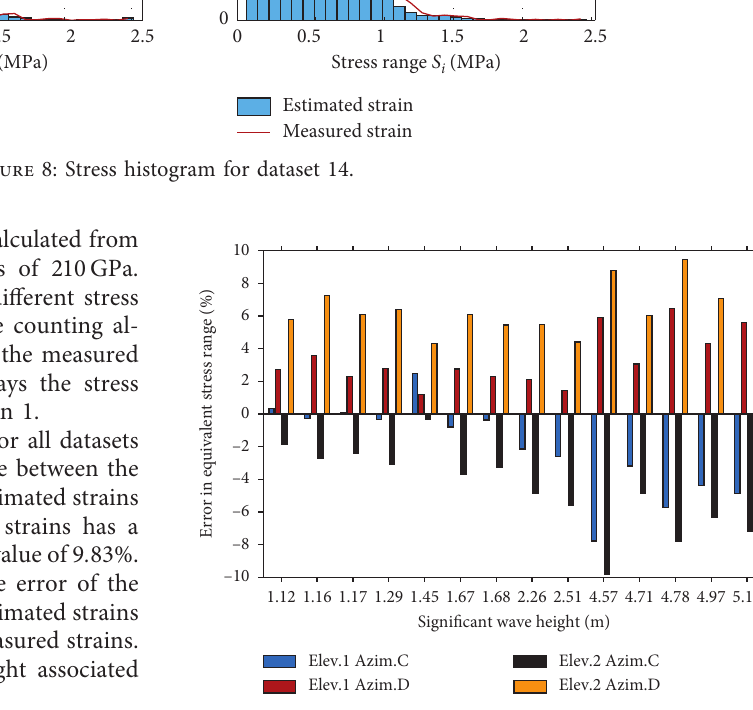
Figure 9: Error in equivalent stress range based on initial azimuth values.